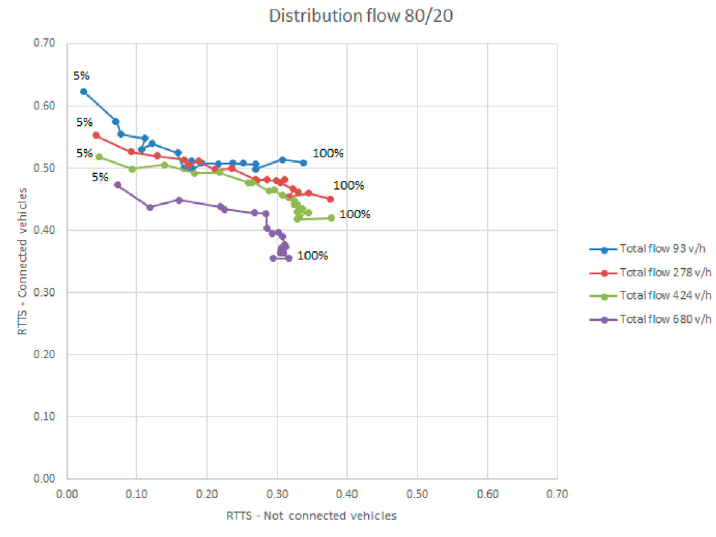
Energies 2018 , 11 , x FOR PEER REVIEW Figure 10. Ratio of Travel Time Saving for traffic light cycle A (Distribution of flow 80/20).